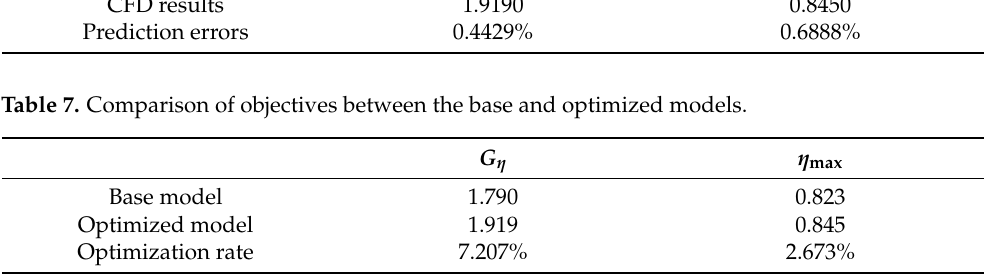
Table 6. Comparison of CFD simulation and two-objective optimization results.